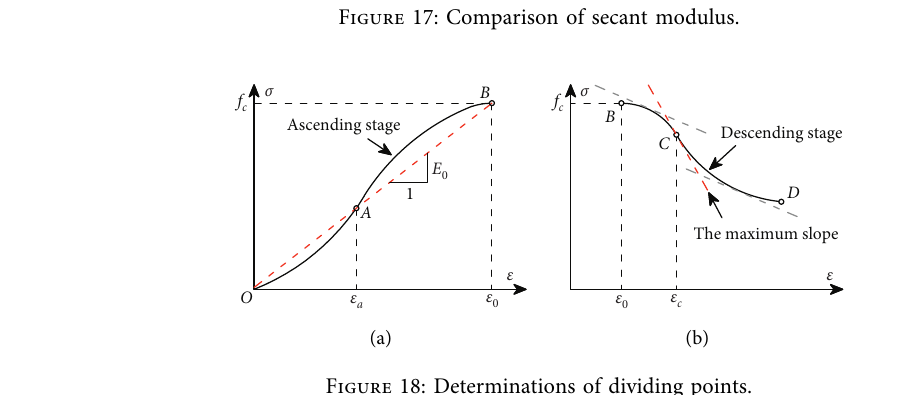
Figure 17: Comparison of secant modulus.